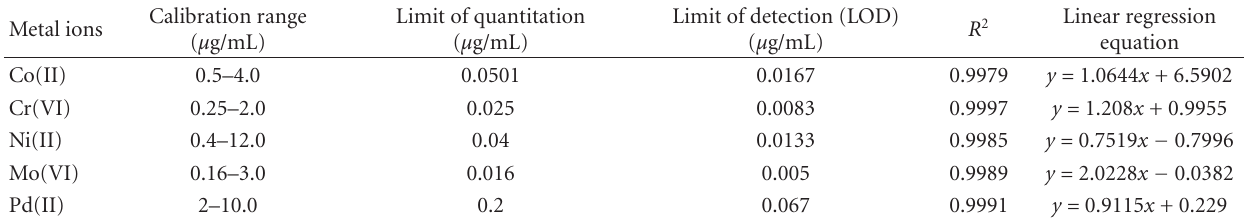
Table 1: Quantitative MEKC Data of DEDTC metal chelates.